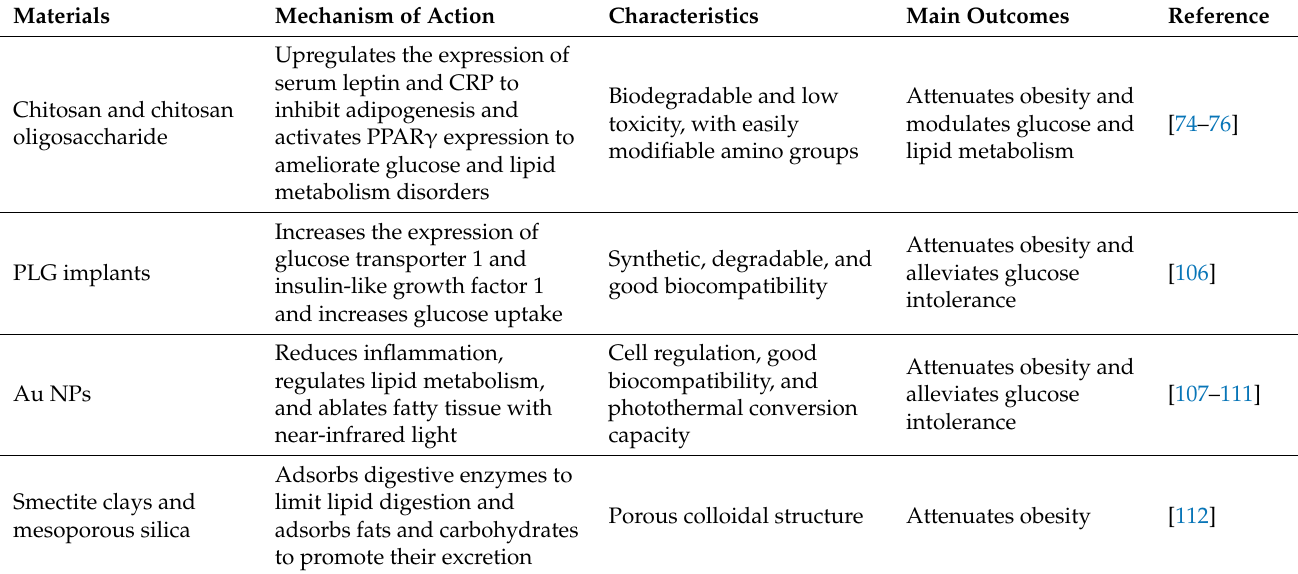
Table 2. Biomaterials with inherent anti-obesity